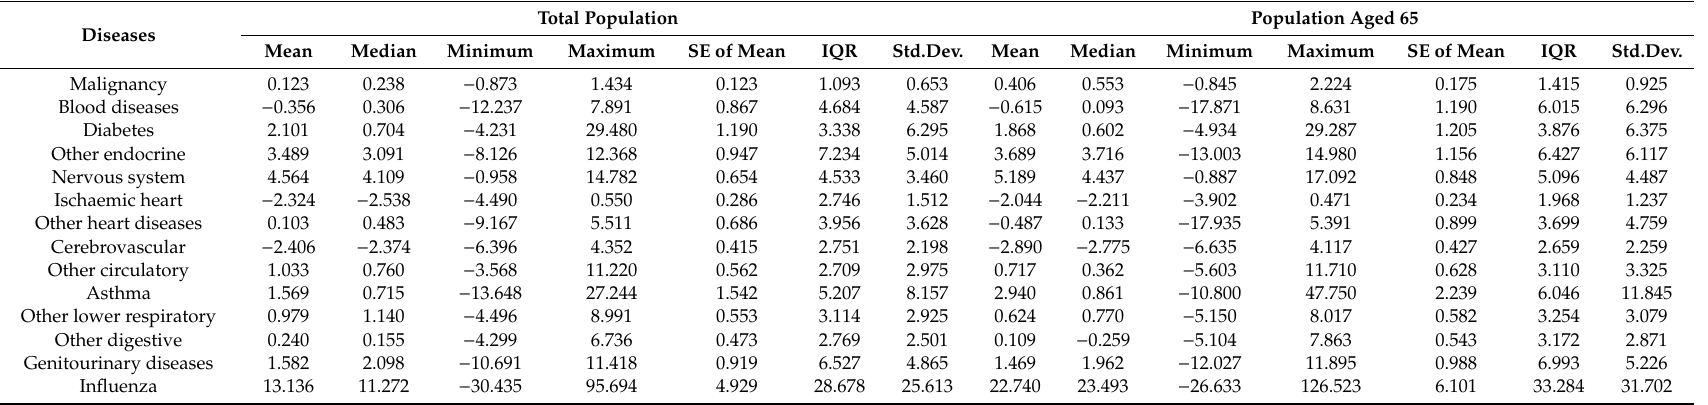
Table 3. Descriptive statistics of COVID-19 comorbidity SOD CAGRs for 28 countries in the European Union—an average of 2011–2016 (percentages).